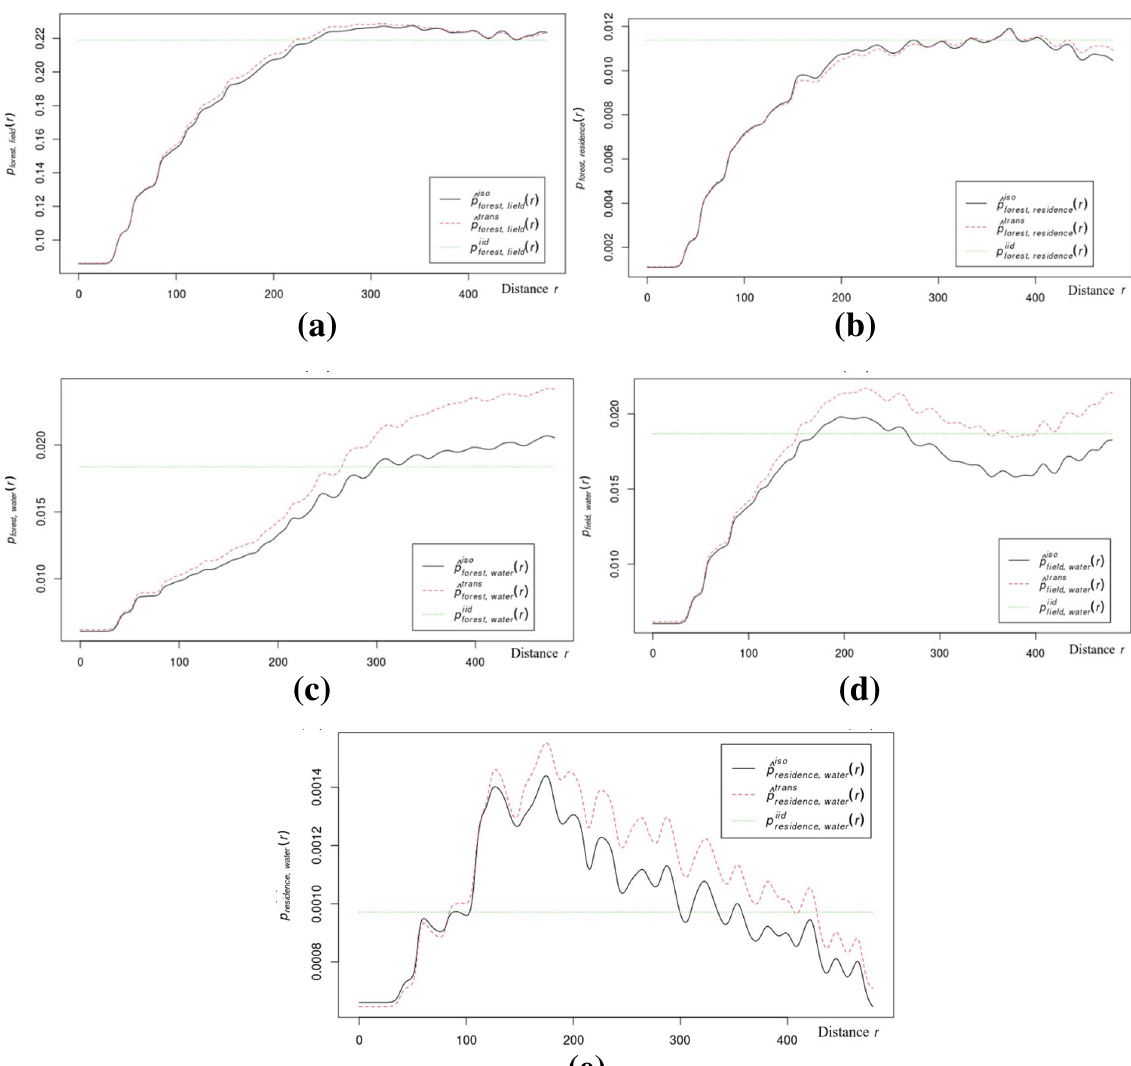
Figure 3. Plots of mark connected functions for bivariate marked point pattern. ( a ) “forest-water”; ( b ) “forest- residence”; ( c ) “water-forest”; ( d ) “water-field”; ( e )